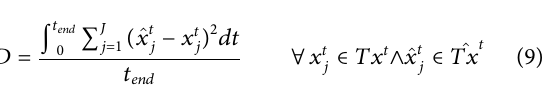
FIGURE 11 | On top, average height after contact in the case of hard (A) and soft (B) dummies. On the bottom, the maximum recorded taxels ’ value (C) and the trials ’ average momentum (D) , both used to quantify the strength of the interaction between robot and environment.